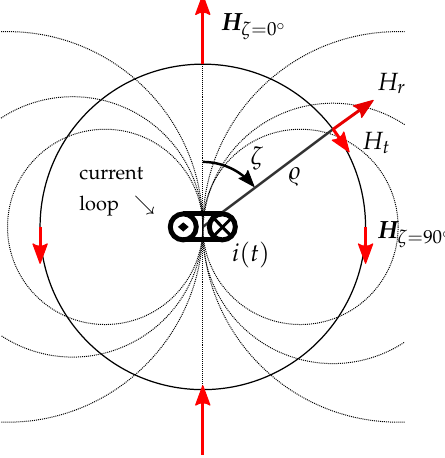
Figure 3. Magnetic dipole field